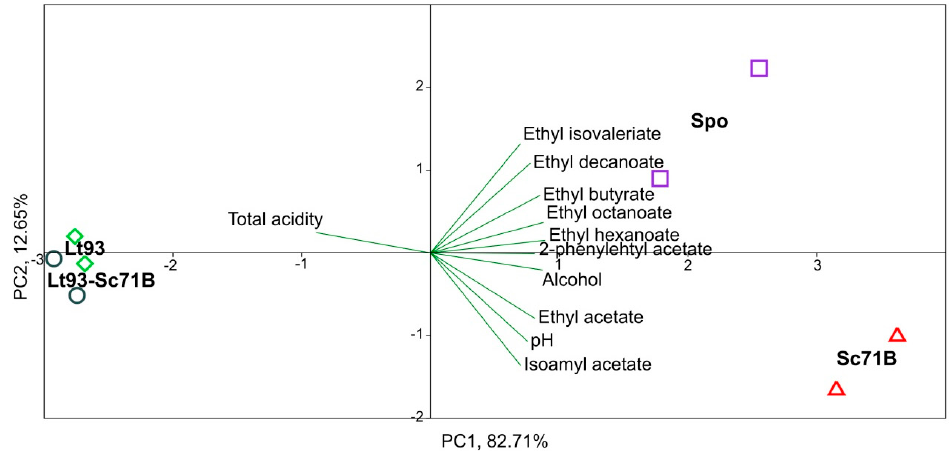
Figure 6. Principal component analysis of Mencía wines (PCA): biplot for the first two components (PC) for volatile compounds with OAV > 1, alcohol content, total acidity and pH. Wines were from fermentation with the following yeasts: Sc71B— S. cerevisiae Sc71B; Lt93— L. thermotolerans Lt93; Lt93-Sc71B— L. thermotolerans Lt93 and sequential inoculation of S. cerevisiae Sc71B; Spo: spontaneous fermentation.